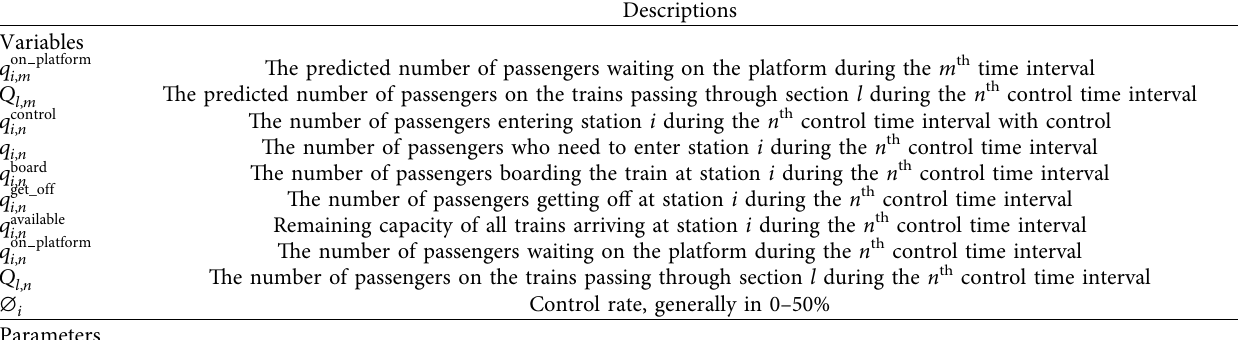
Table 1: List of